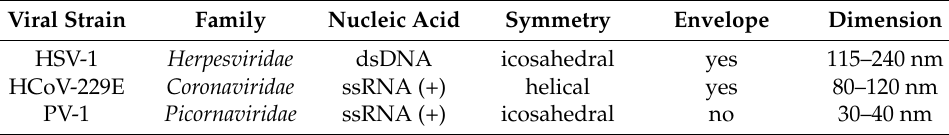
Table 1. Main characteristics of the viral species used to evaluate the antiviral activity. Viral Strain Family Nucleic Acid Symmetry